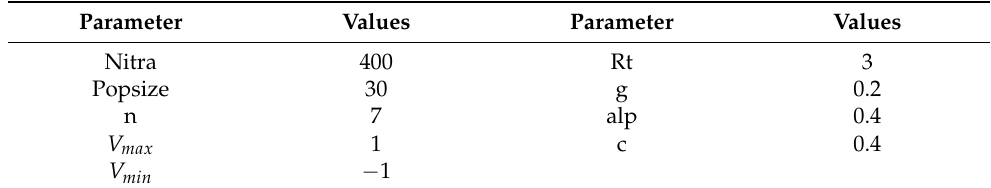
Table 4. WDO algorithm parameters specification.